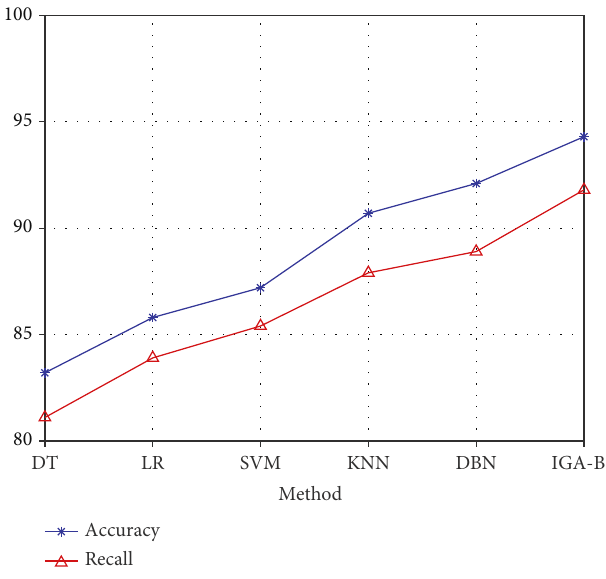
Figure 3: Performance of di ff erent